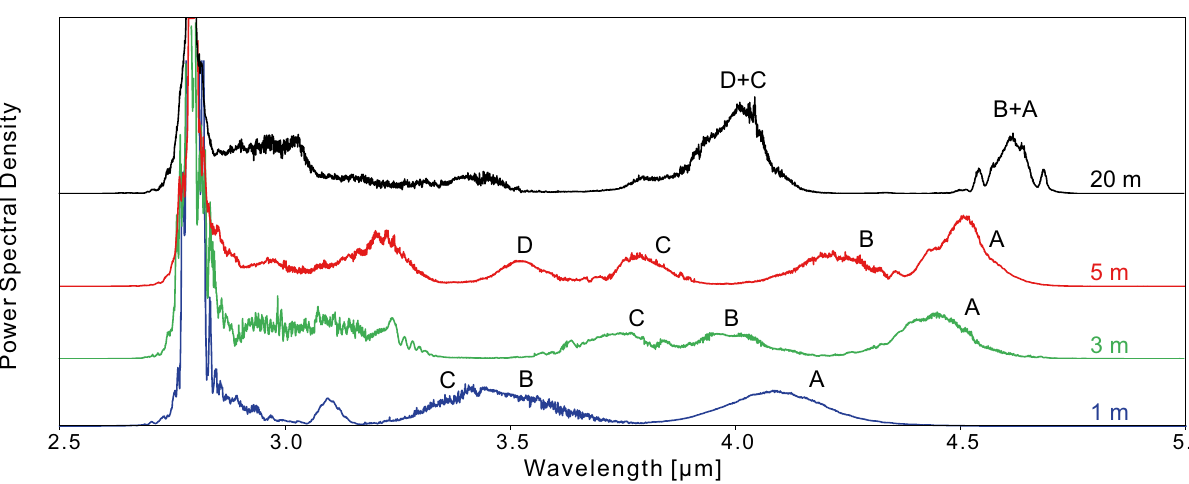
Figure 4. A redshidfted soliton at 4.8 µm is achieved when pumping at 70 W with a 25% duty cycle.